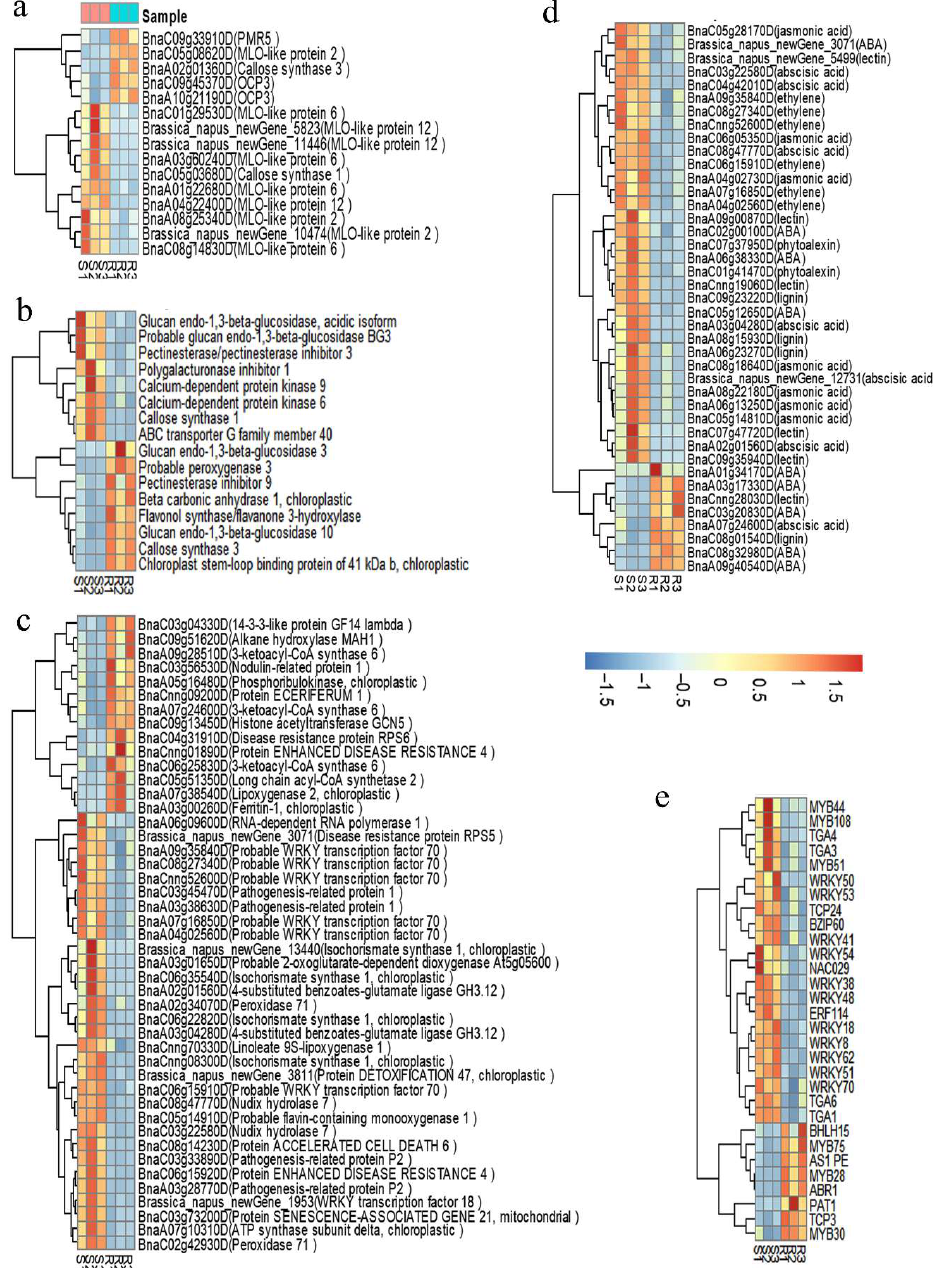
Figure 6. Heatmap of five subsets of the selected differentially expressed genes in the foliar transcriptomes of the S/R plants in the BC 1 F 3 segregated population. These genes encode the proteins related to ( a ) PM S/R, ( b ) cell wall structure, ( c ) disease resistance, ( d ) transcription factors and ( e ) plant hormone signaling, respectively.